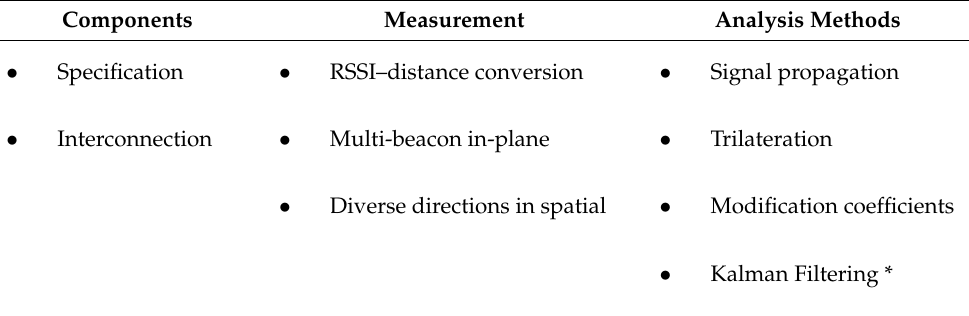
Table 1. The portions in the practice of the BLE measurements.